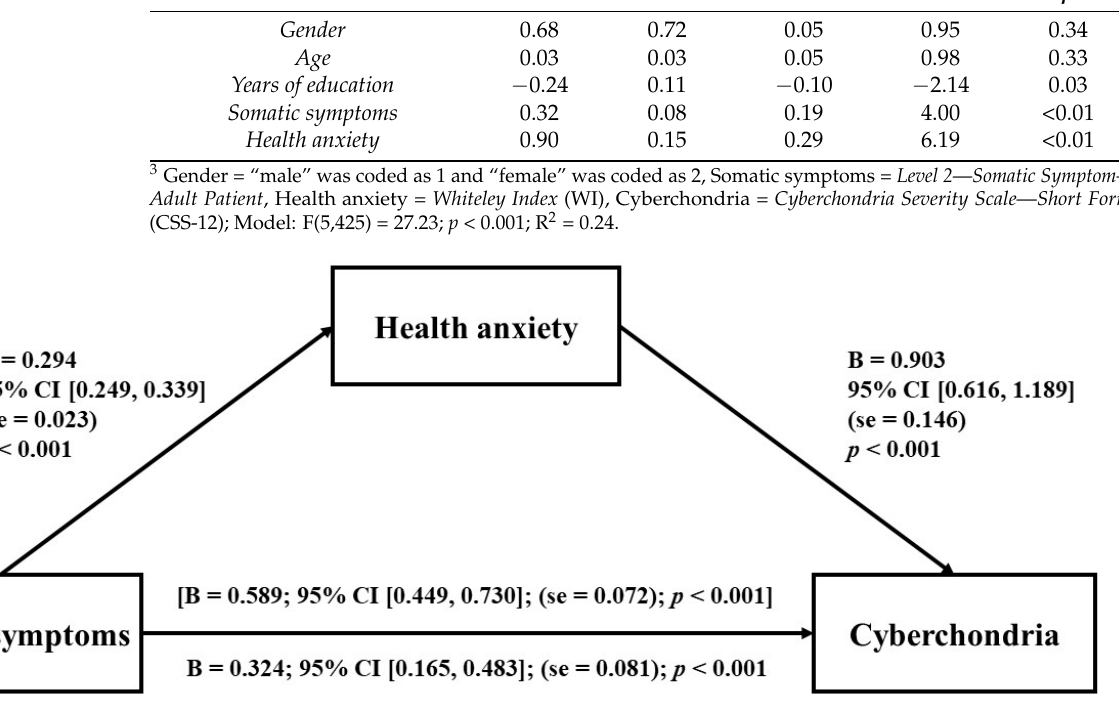
Table 3. Regression model predicting the severity of cyberchondria 3 .